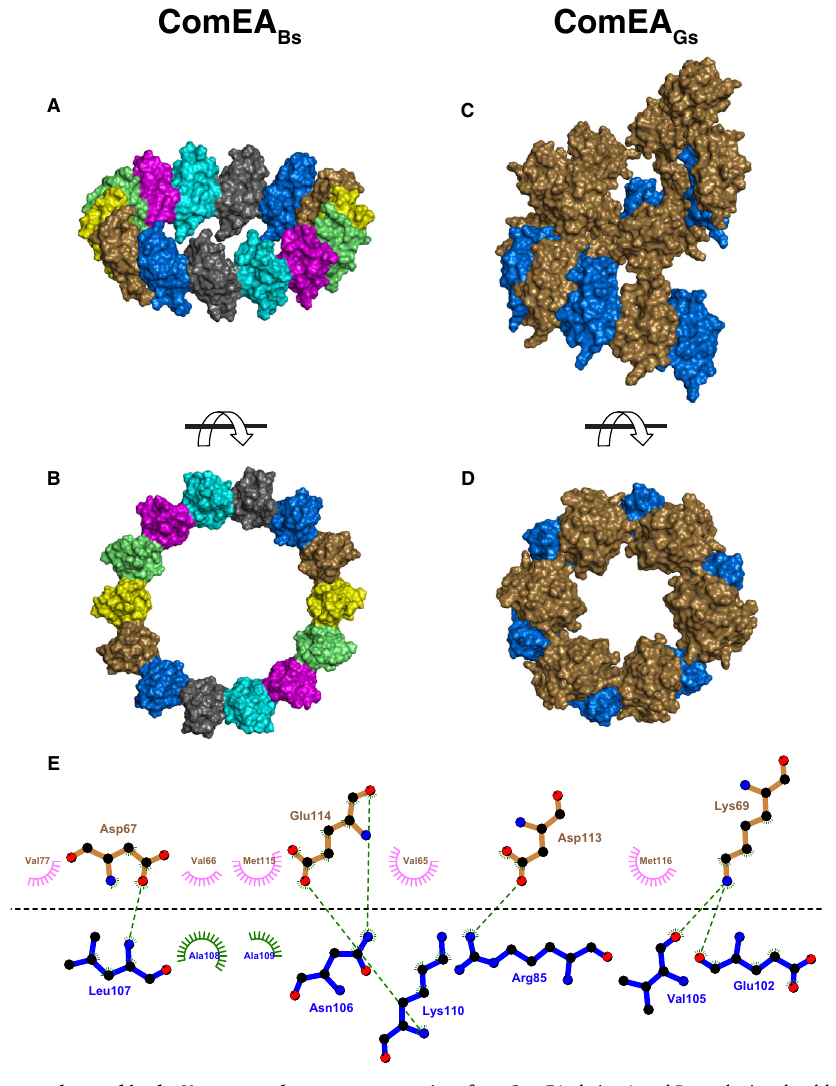
interface. ComEA chains A and B are depicted as blue and brown bonds, respec- tively. Hydrogen bonds are depicted as green dashed lines. Hydrophobic contacts aredepictedaslinesradiatingfromthesemicirclesandspheres.Theschematicwas produced with LigPlot+ 50